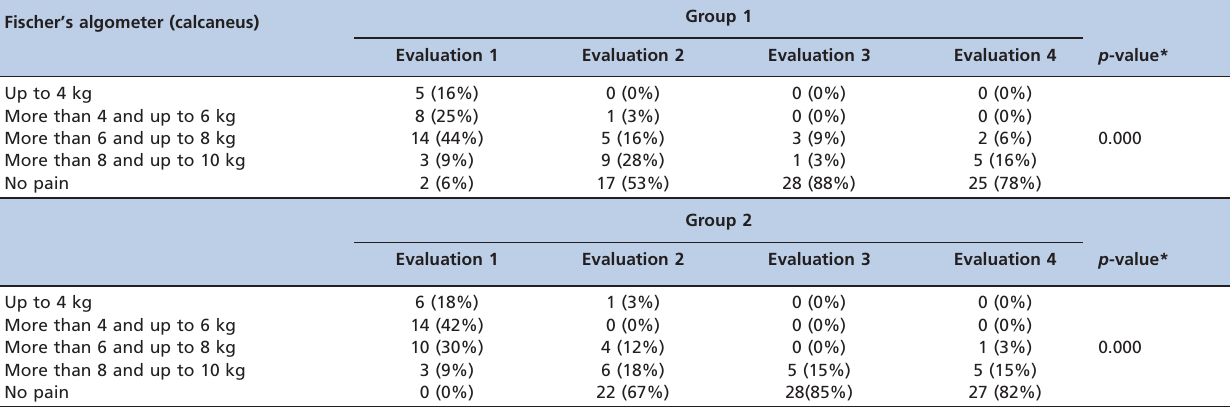
Table 4 - Distribution of patients according to Fischer’s algometer (calcaneus) in groups 1 and 2 before and after the treatment (immediately, three months and one year after the treatment).